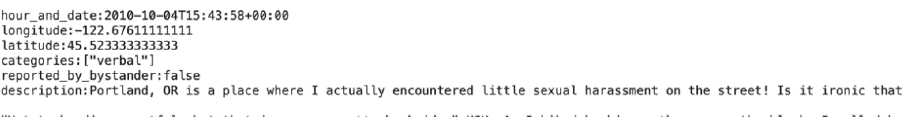
Figure 10. Data structure of one dictionary element coming from the CSV